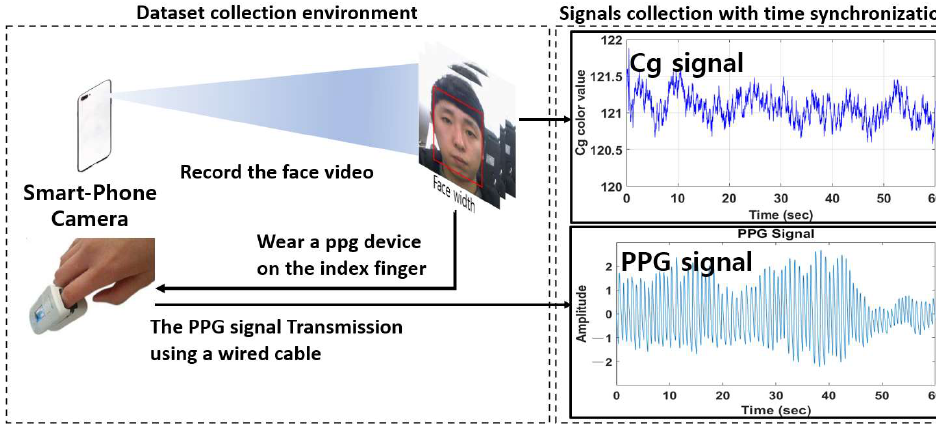
Figure 17. Dataset collection environment for an indoor lab.